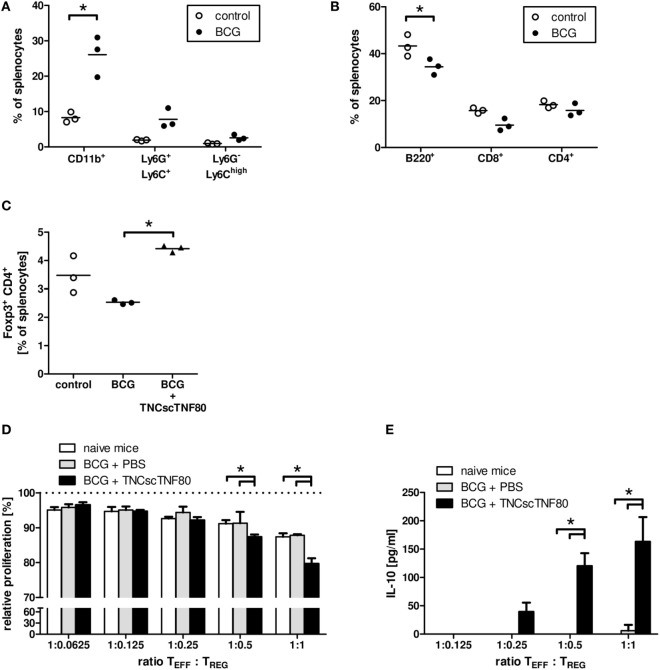
Effects of TNCscTNF80 in the BCG in vivo model of chronic inflammation. The composition of spleen cells from mice immunized with BCG was analyzed. The fractions of myeloid (CD11b+) cells and the immature myeloid cell populations PMN-MDSC (Ly6G+Ly6C+) and MO-MDSC (Ly6G−Ly6Chigh) (A), as well as of B (B220+) and T (CD8+, CD4+) (B) were determined by flow cytometry. The fraction of Treg (CD4+Foxp3+) cells in control mice and in BCG-immunized mice treated or not with TNFscTNF80 was determined by flow cytometry (C). Each symbol represents one mouse. Data are shown from one experiment out of two (A–C). The relative proliferation of activated T cells in the presence of graded numbers of Treg cells from either naïve mice (open bars), BCG-treated mice (gray bars), or BCG and TNCscTNF80-treated mice (black bars) was determined. Data are shown as mean + SD of three mice from one experiment. Proliferation data are normalized to proliferation in cultures without additional Treg cells (D), and concentrations of IL-10 were determined in the supernatants (E).